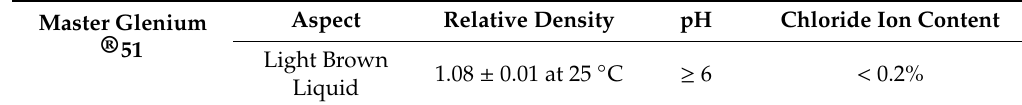
Table 5. Properties of superplasticizer.